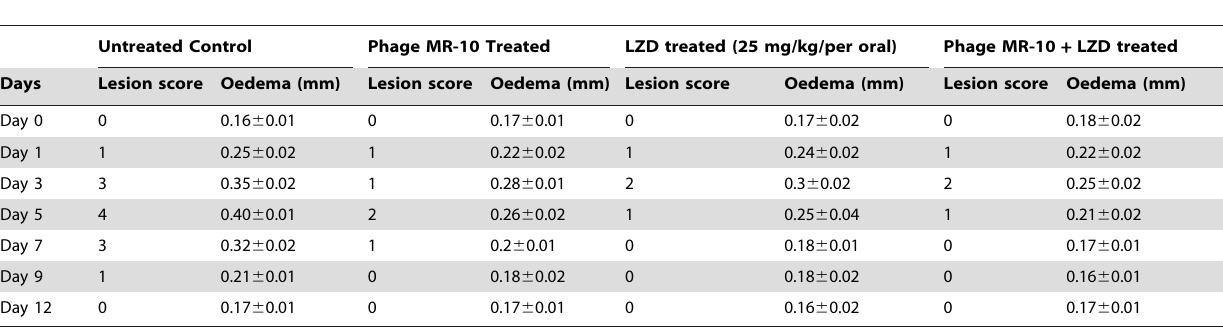
Table 2. Lesion score with oedema values on different days post-infection in diabetic mice treated with phage MR-10, linezolid (LZD) and combination of both.